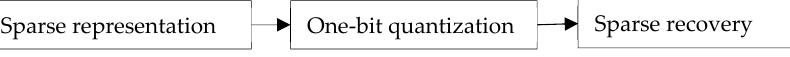
Figure 10. Theoretical framework of one-bit compressive sensing [92,99–105].